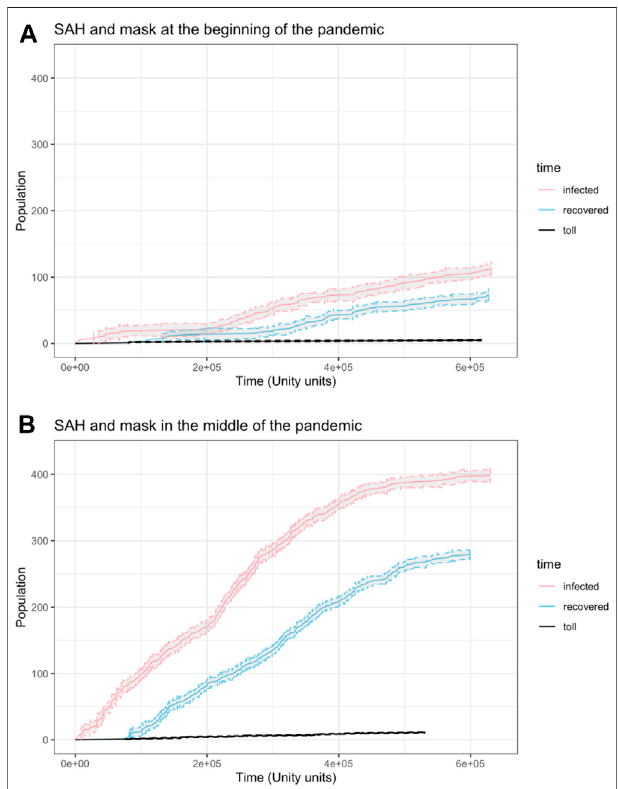
FIGURE 3 | The results of implementing both public health intervention methods on infection rate at different phases of the pandemic: (A) both interventions implemented at the beginning phase (B) both interventions applied in a later phase of the